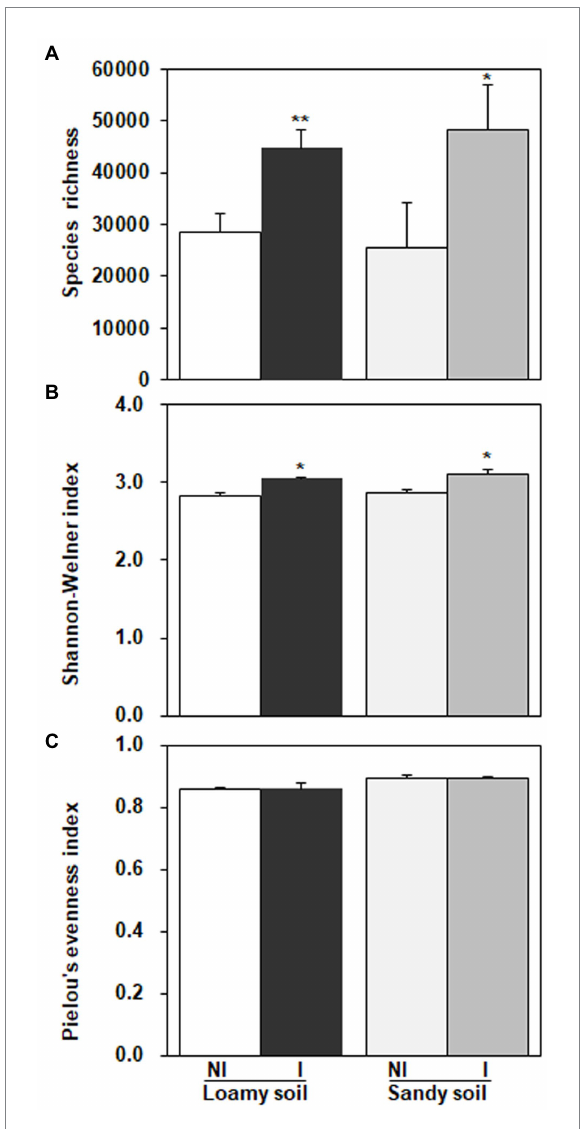
FIGURE 7 Diversity indexes obtained from the restriction enzyme Hha I in loamy and sandy soil with and without inoculation of Enterobacter cloacae NG-33 strain. (A) Species richness, (B) Shannon-Weiner index, (C) Pielou’s evenness index. The difference between the means is significant at p < 0.05 (*) and p < 0.01 (**)